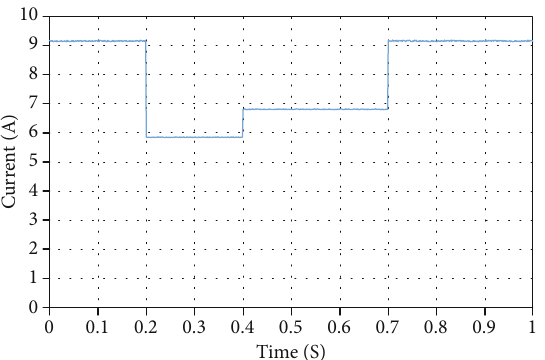
Figure 36: The output current of